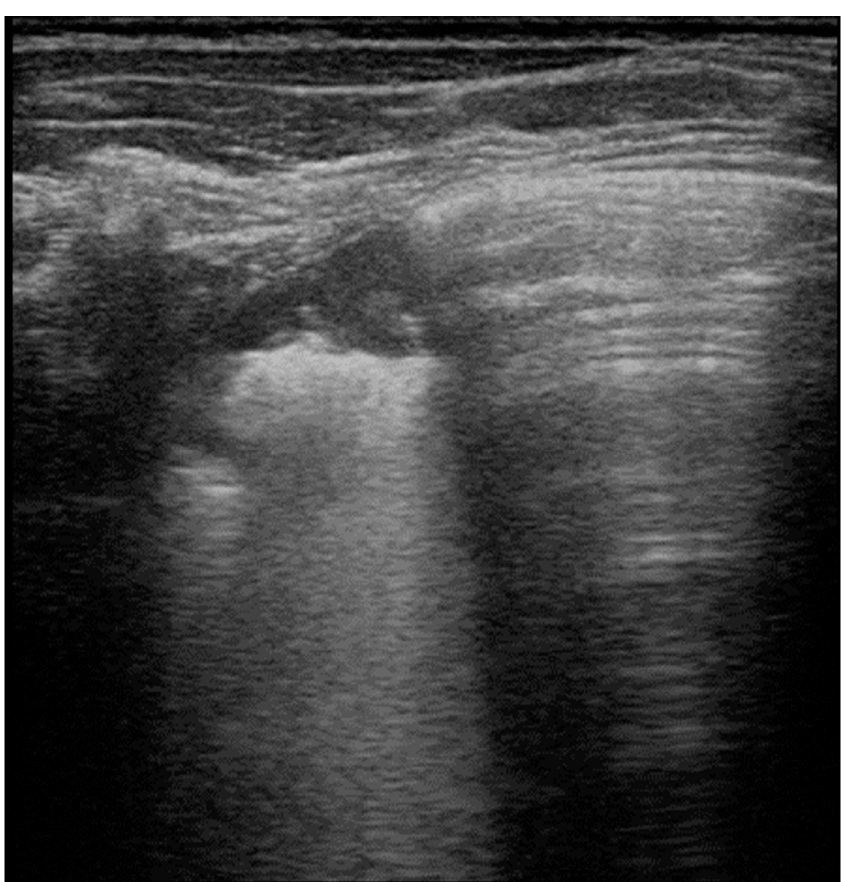
Figure 4. Mycoplasma pneumonia: area of consolidation (lung hepatization) with blurred margins and disappearance of pleural line. Adjacent to the affected area, evidence of normal A-lines, i.e., hyperechoic horizontal lines deeper than visible pleural line, parallel and equidistant from one another that are able to exclude the presence of lung pathologies in the scanned area.